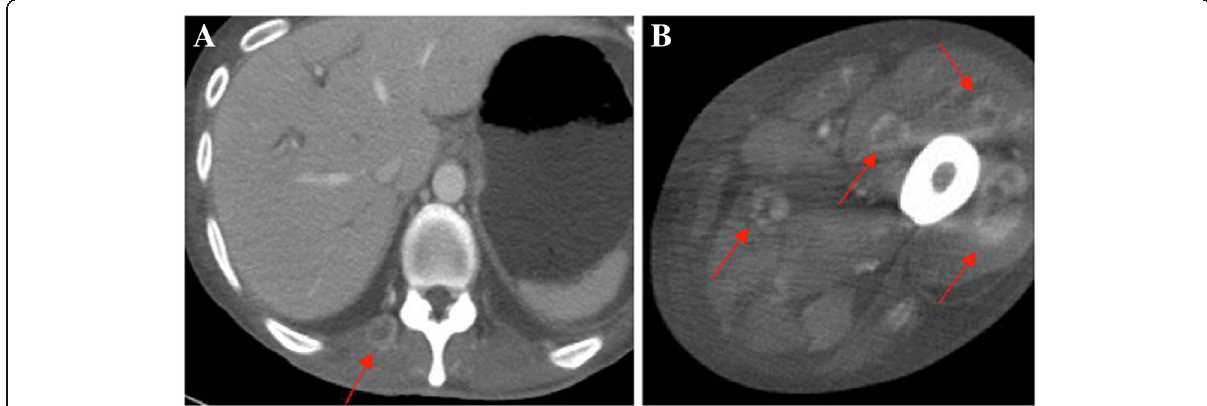
Fig. 4 The metastases was extended to paraspinal ( a ) and quadriceps muscle ( b ) (arrows)